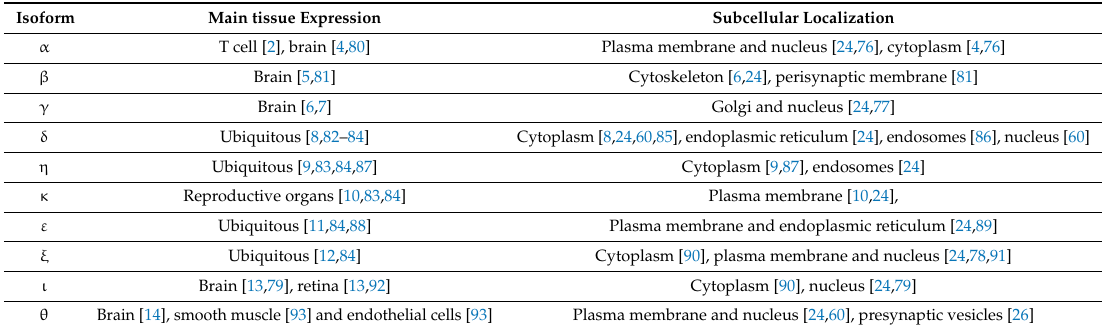
Table 1. Expression pattern and subcellular localization of DGK